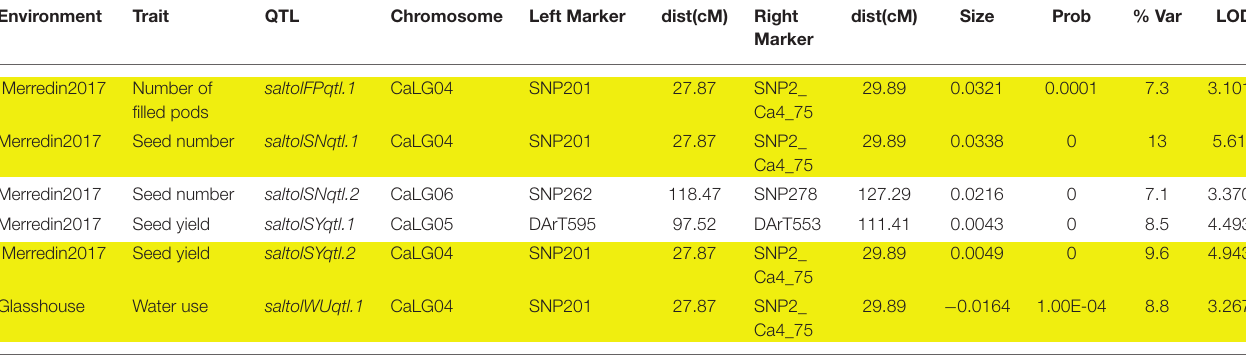
TABLE 6 | Salinity tolerance QTL: QTL obtained from residuals from the regression line when salinity BLUPs are regressed on control BLUPs. Environment